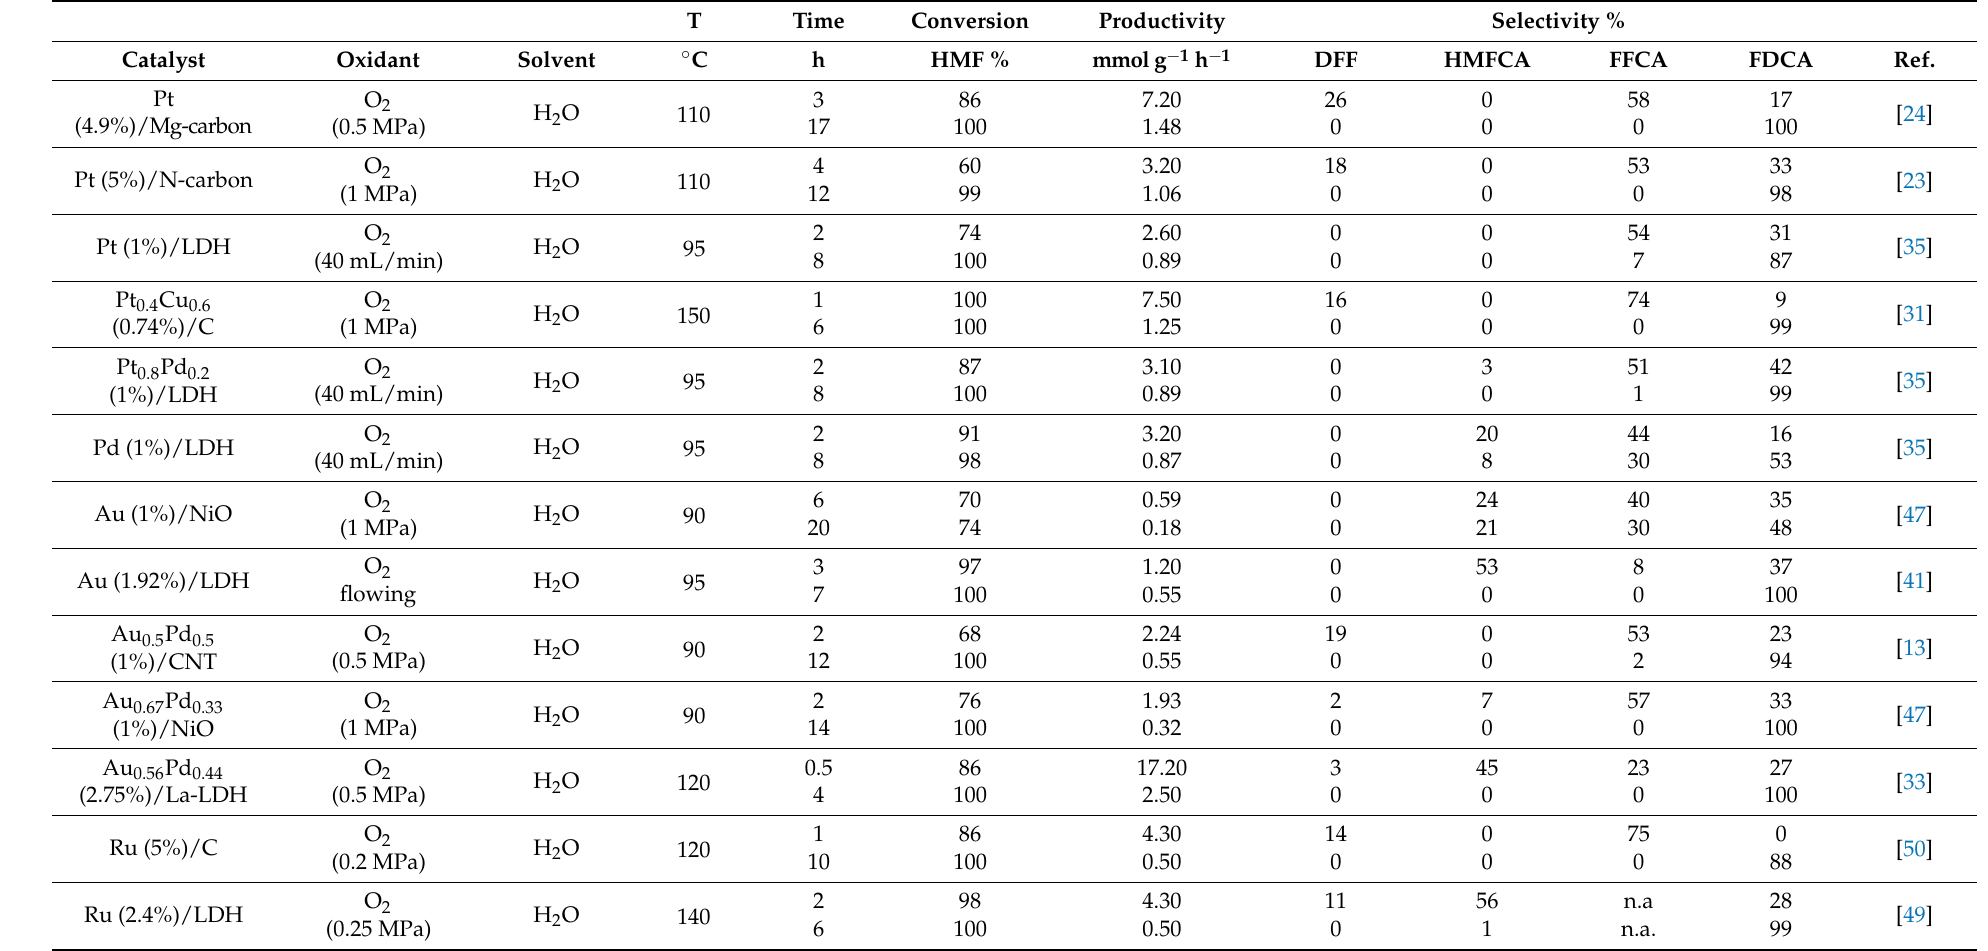
Table 1. Selected literature results of base-free HMF oxidation on supported noble metal